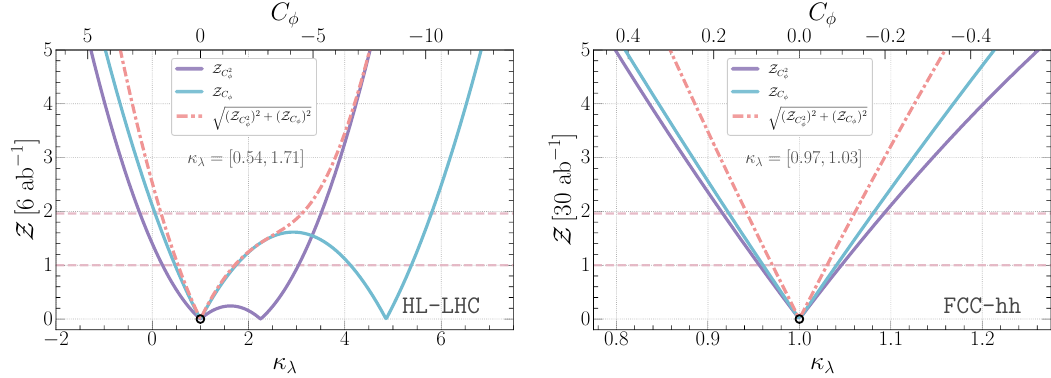
Figure 5 . Bounds on κ λ (or C φ ) at the HL-LHC (left panel) and the FCC-hh (right panel). The solid blue lines are the constraints coming from the hh gg F contribution which scales linearly with int the modified coupling and the solid purple line is that from the hh gg F contribution that scales tri quadratically with the modified coupling. The red dot-dashed line is the combination of the quadratic and linear channel. The horizontal light red dashed lines mark the 68% and 95% confidence intervals. The 68% CL bounds on κ are given within square λ